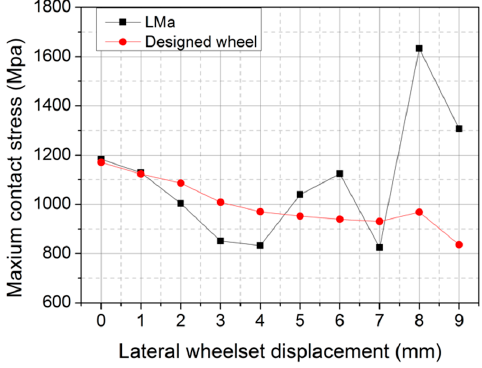
Figure 21. Maximum wheel-rail contact stress at different lateral wheelset displacement.